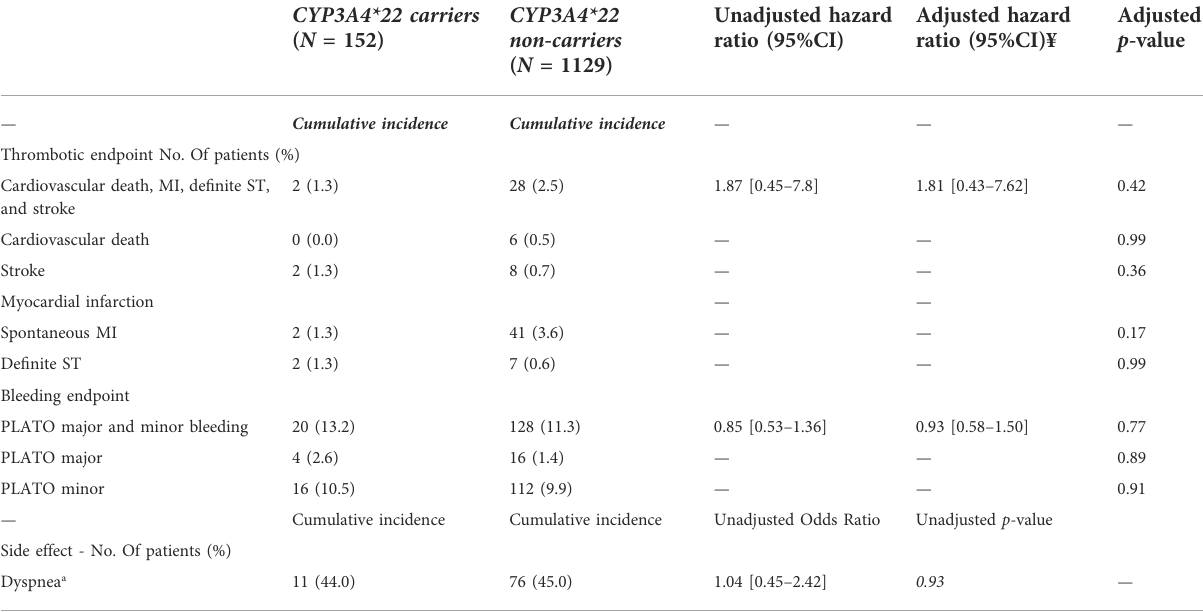
TABLE 2 Clinical endpoint for CYP3A4 in patients treated with